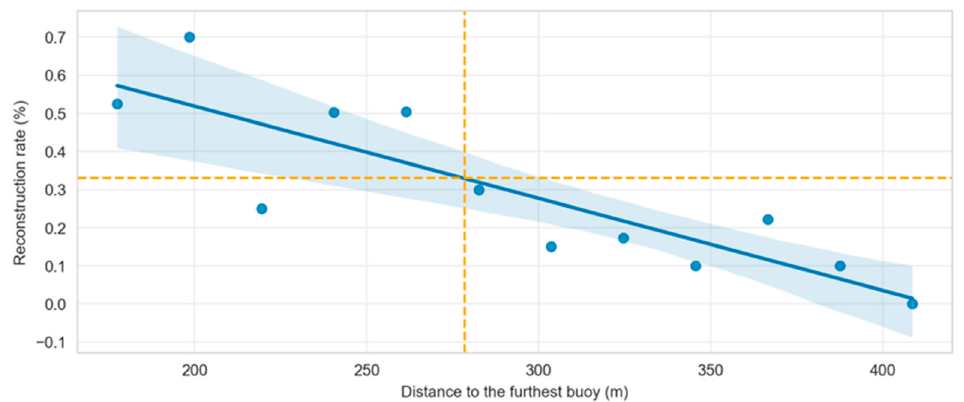
Figure 10. The reconstruction rate obtained in the context of our experiment with a maximum distance of 429.5 m from the furthest acoustic receiver. A linear regression was applied between 0 and 429.5 m to estimate the distance at which the 33% threshold is reached. Mean (blue line) and confidence intervals (light blue area) of the regression are displayed.